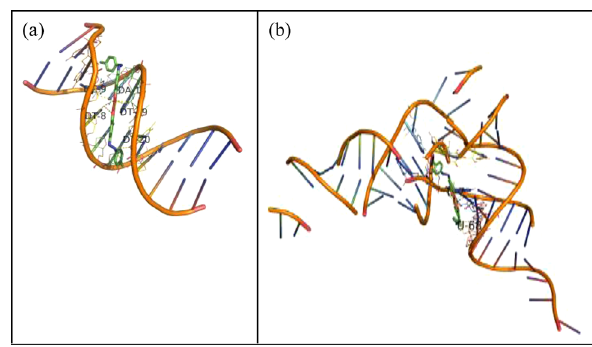
Figure 7: Molecular docked model of 1 ( a ) with DNA dodecamer duplex and ( b ) with RNA